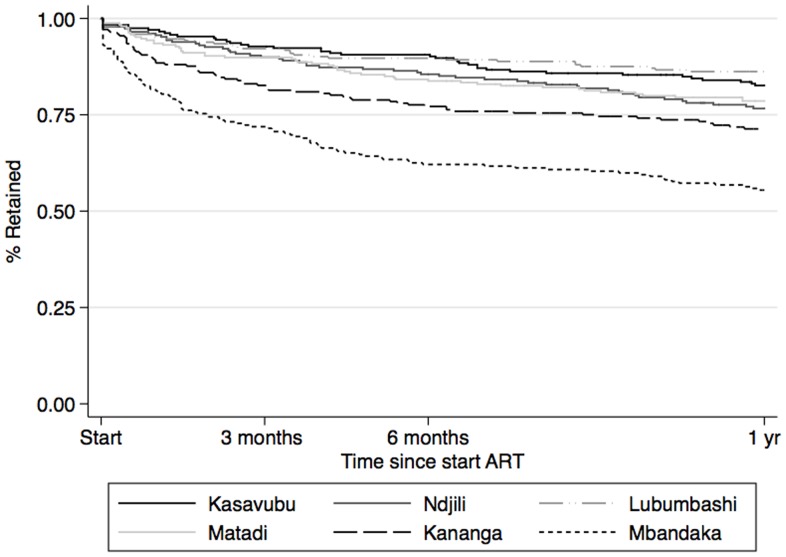
Proportion of patients discontinuing from the AmoCongo ART program at 1 year by the 6 study sites.